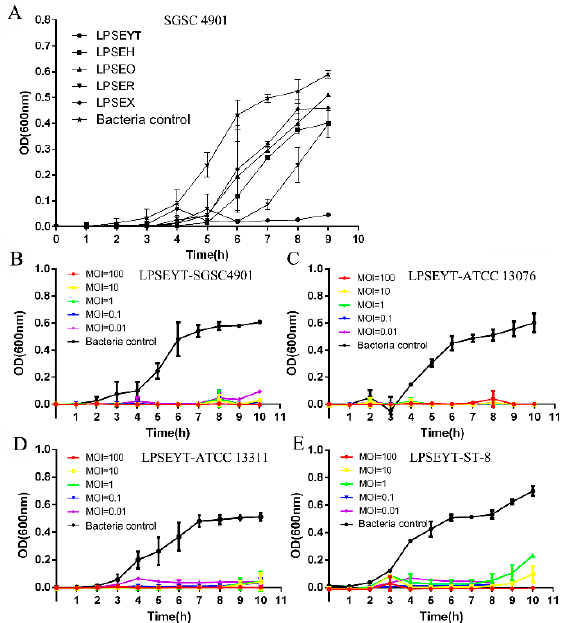
Figure 1. Lytic ability of isolated phages. ( A ) The antimicrobial efficacy of isolated phages against S